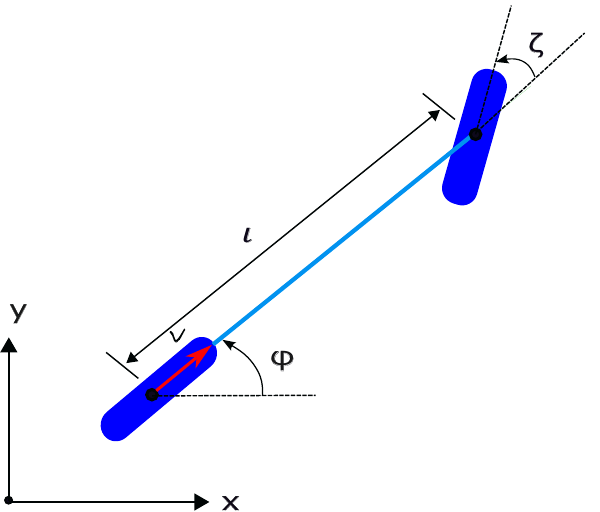
Figure 3. Schematics of the vehicle dynamics